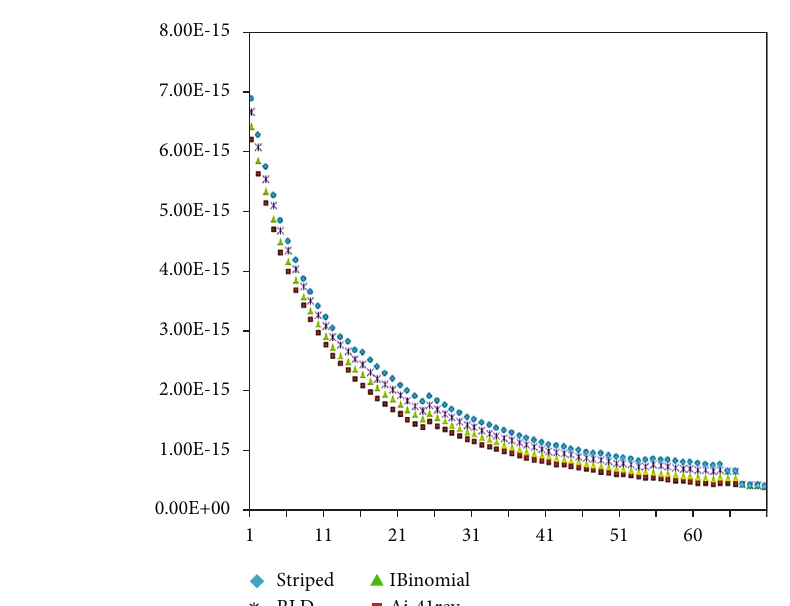
Figure 3: 1000 points from our scrambled Faure